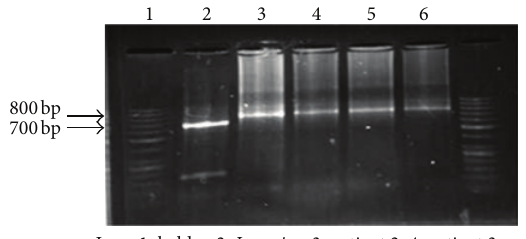
Figure 10: Shows PCR results of patients 2 and 3.